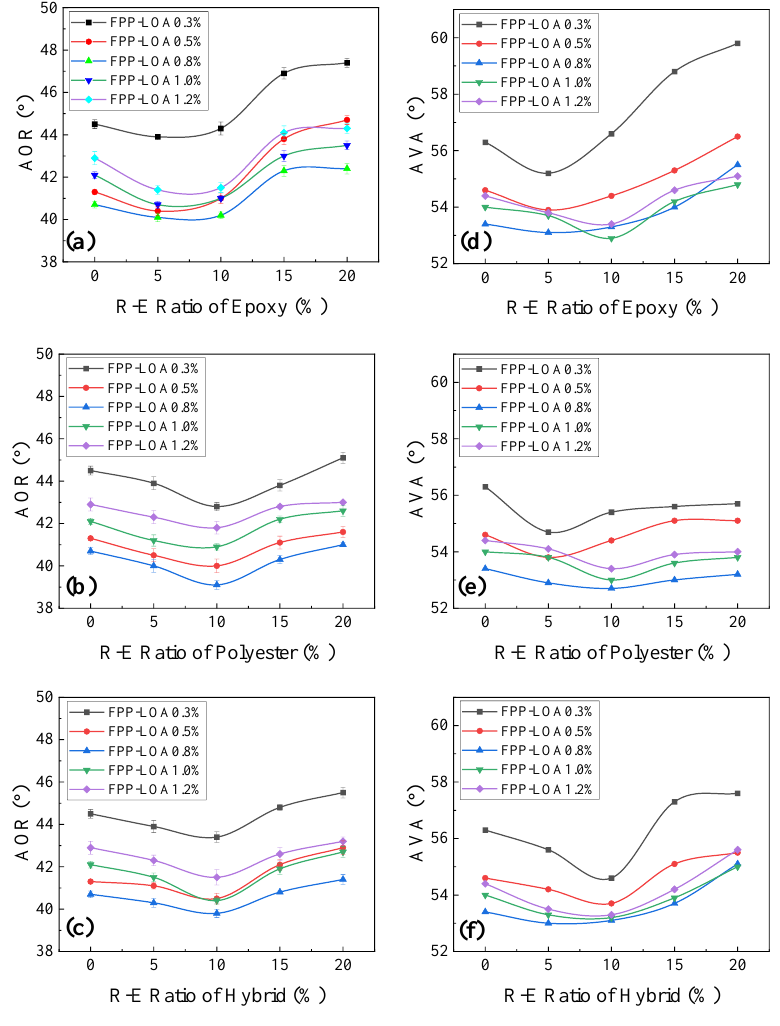
Figure 7. Effects of R-E ratio on AOR and AVA. ( a , d ) FPP-EY; ( b , e ) FPP-PE; ( c , f ) FPP-HY.